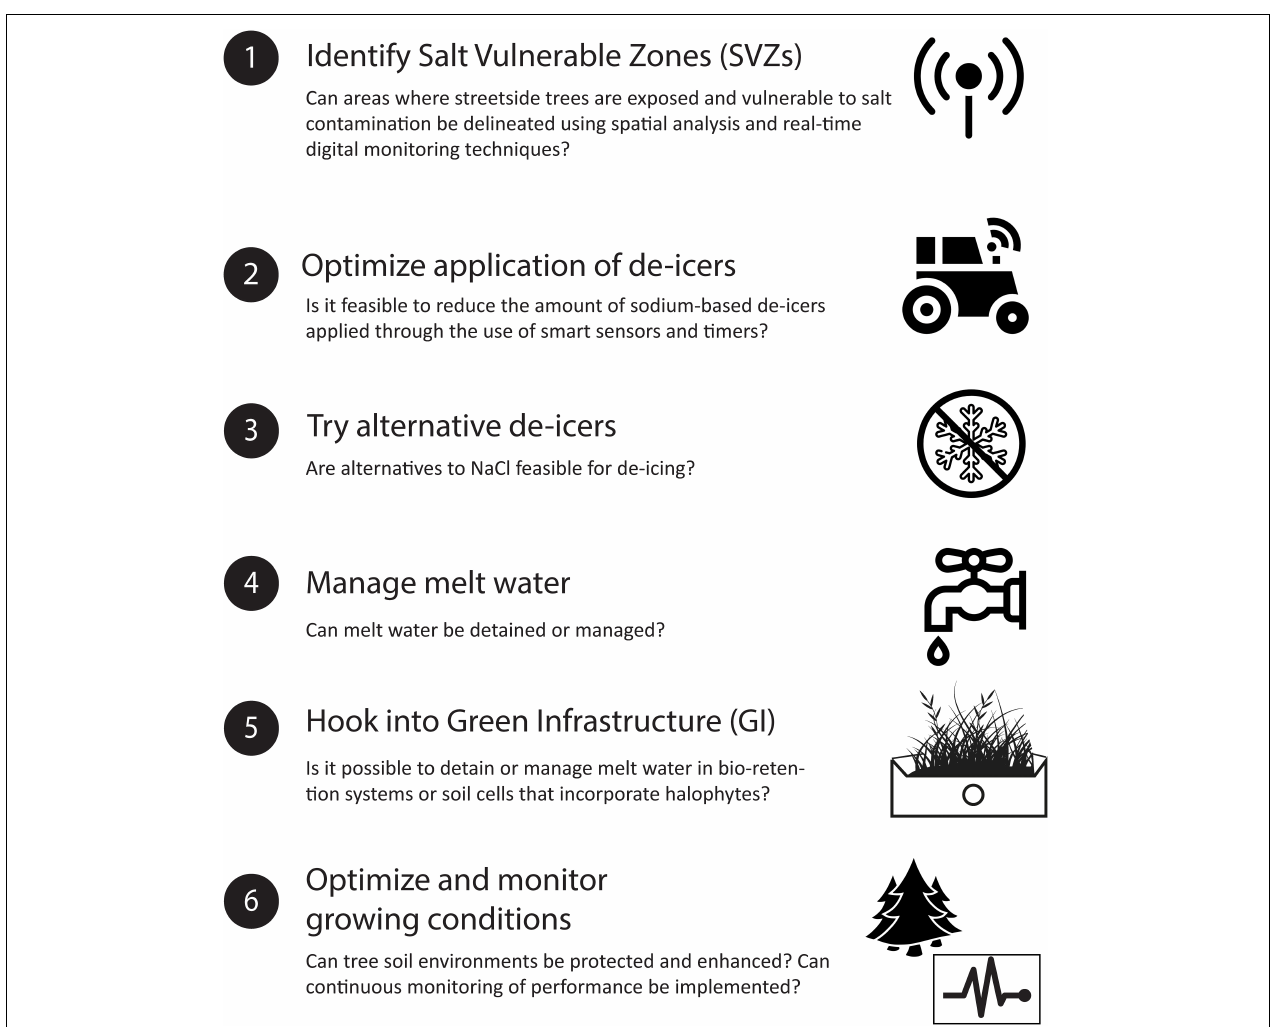
FIGURE 2 | Actions can be conceived and executed as a progressive set of steps that build on one another, from the optimization of de-icing salt application (2) to the integrative solutions of (5) and (6). The action items are not exclusive of one another in that the completion of one does not suggest that no further action should be taken. The delineation of Salt-Vulnerable Zones (1) is arguably a necessary precursor to the other